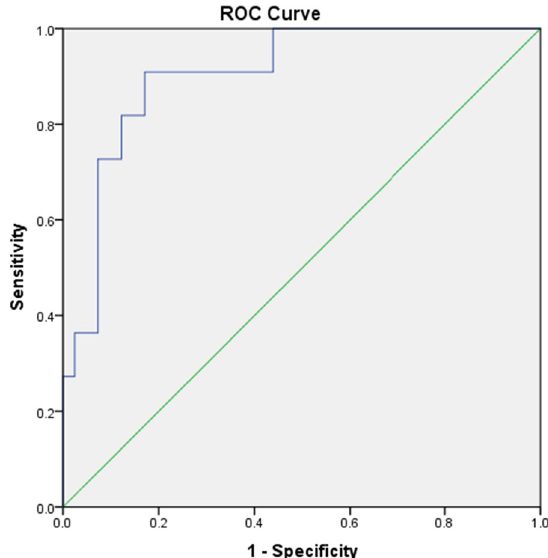
Fig. 1 Receiver operating characteristic curve for differentiation of Ishak stage 0–1 from stage 2 or higher. *Area Under Curve 0.760 (95% CI 0.618–0.901) ( p 0.003) =